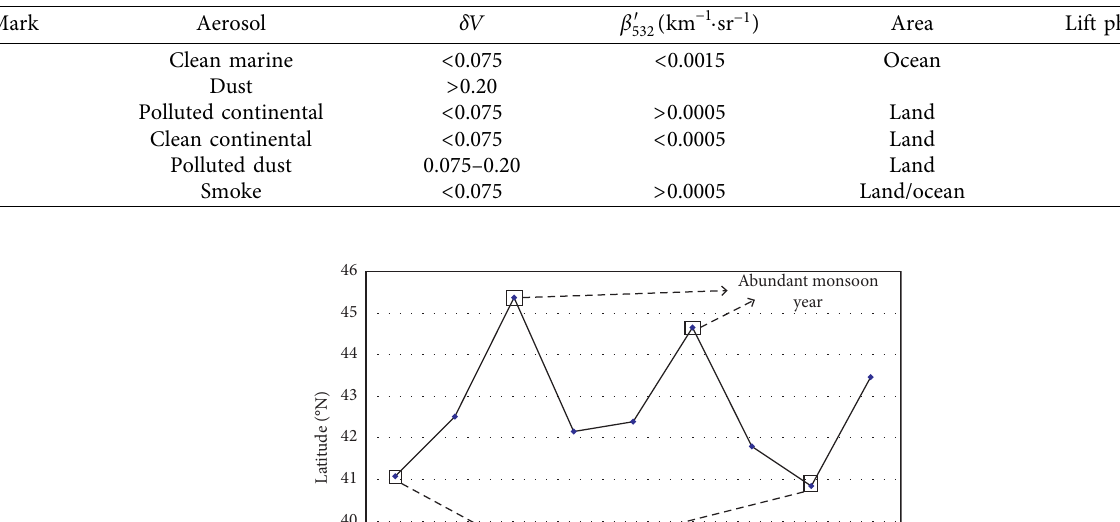
Table 1: Level 2 dataset aerosol classification.